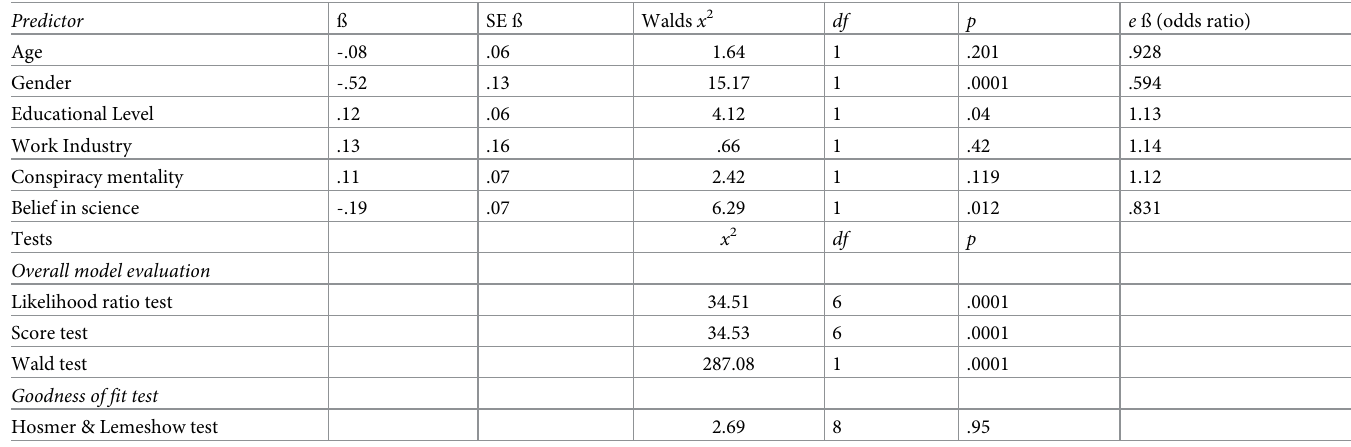
Table 7. Logistic regression